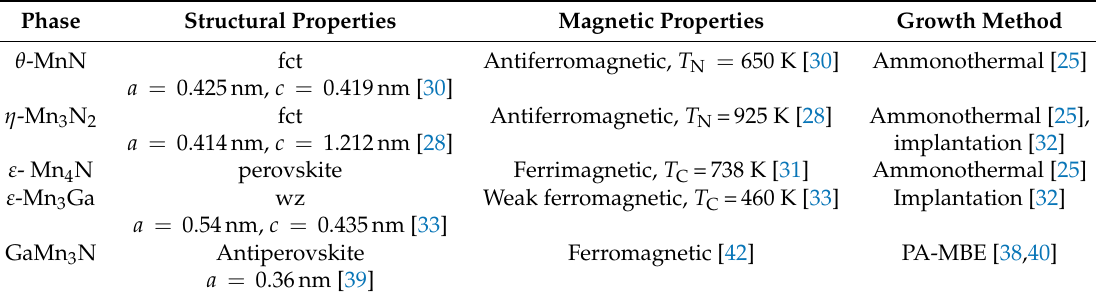
Table 1. Observed secondary-phases in Ga 1 − x Mn x N, their structural and magnetic properties, as well as the growth technique employed for the growth of the phase-separated